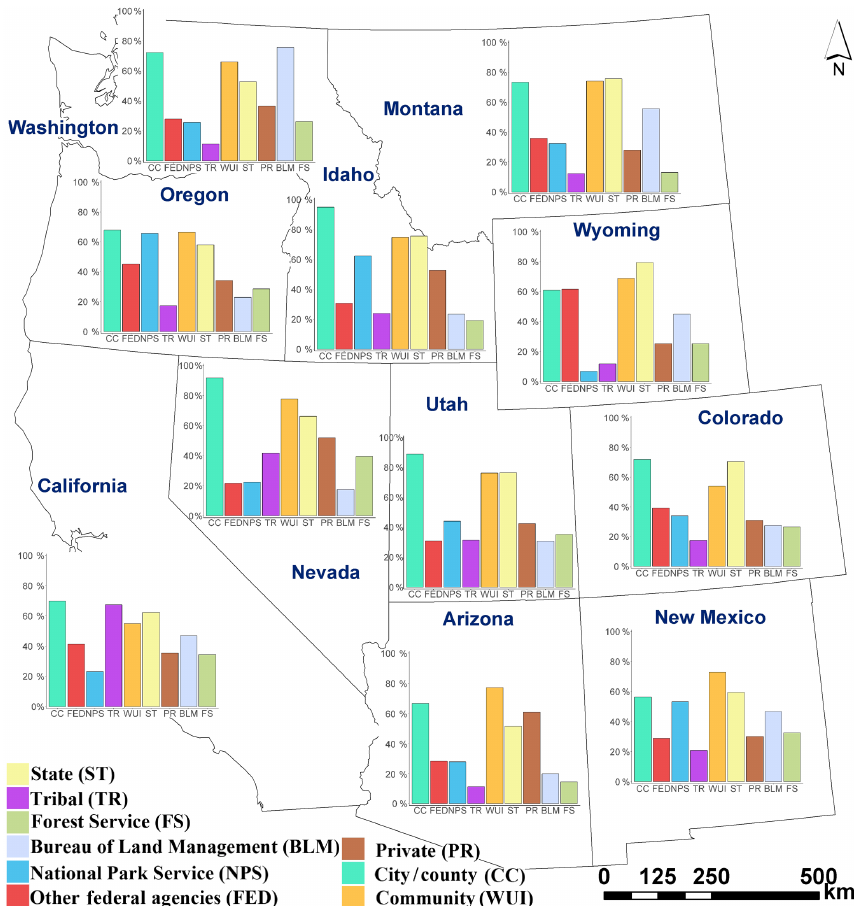
Figure 3. Proportion of incoming fire to the total fire (incoming/(incoming + self-burning) · 100) for each western US state. The public land tenure was merged with city/county, while all smaller federal land tenures were merged into the other federal agency